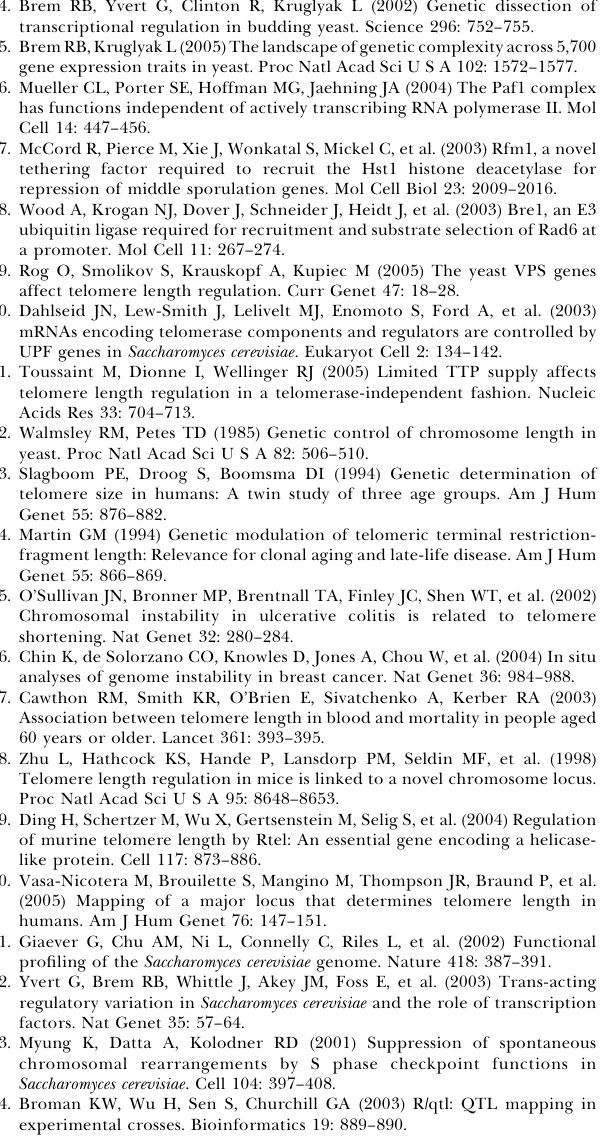
Figure S1. TLM Genes Affect Senescence Rate Independently of RAD52 -Mediated Homologous Recombination Pathway Spores derived from TLC1/tlc1 TML/tlm RAD52/rad52 heterozygous diploid strains were allowed to germinate, and haploid single rad52 , double rad52 tlc1 , rad52 tlm , and triple rad52 tlc1 tlm mutants were streaked-out successively on rich medium. The strains with triple